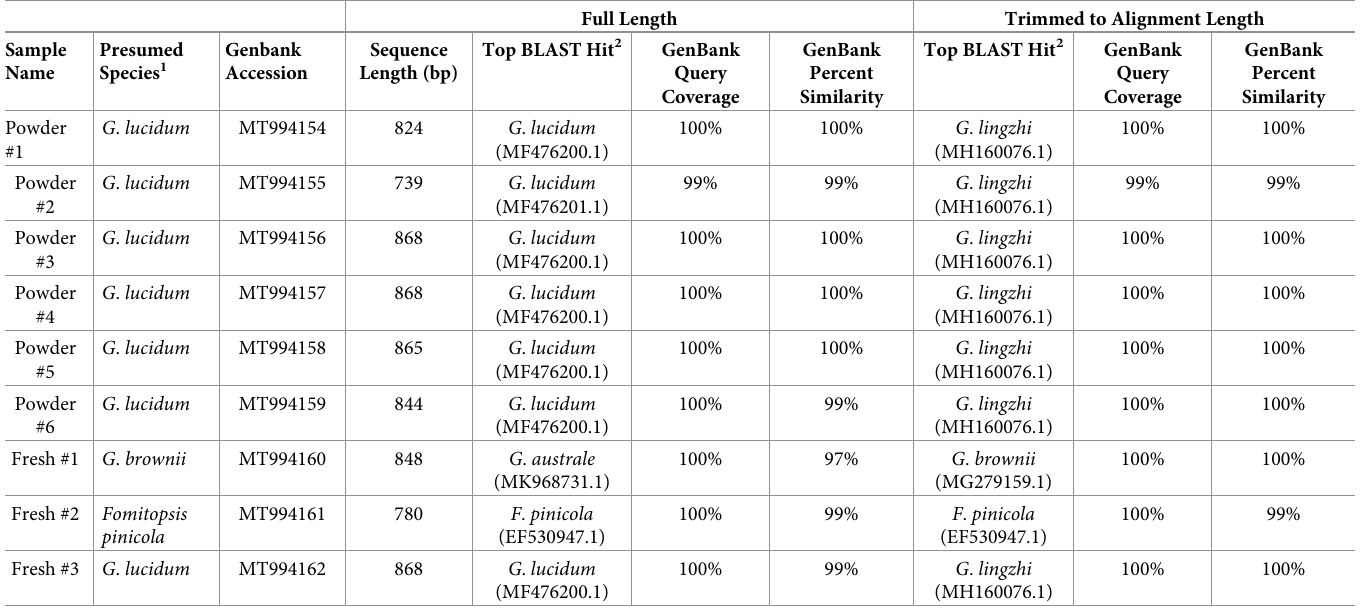
Table 2. BLAST results using full length ITS sequences compared to ITS sequences trimmed to the GenBank reference panel alignment (618 bp) used in phyloge- netic